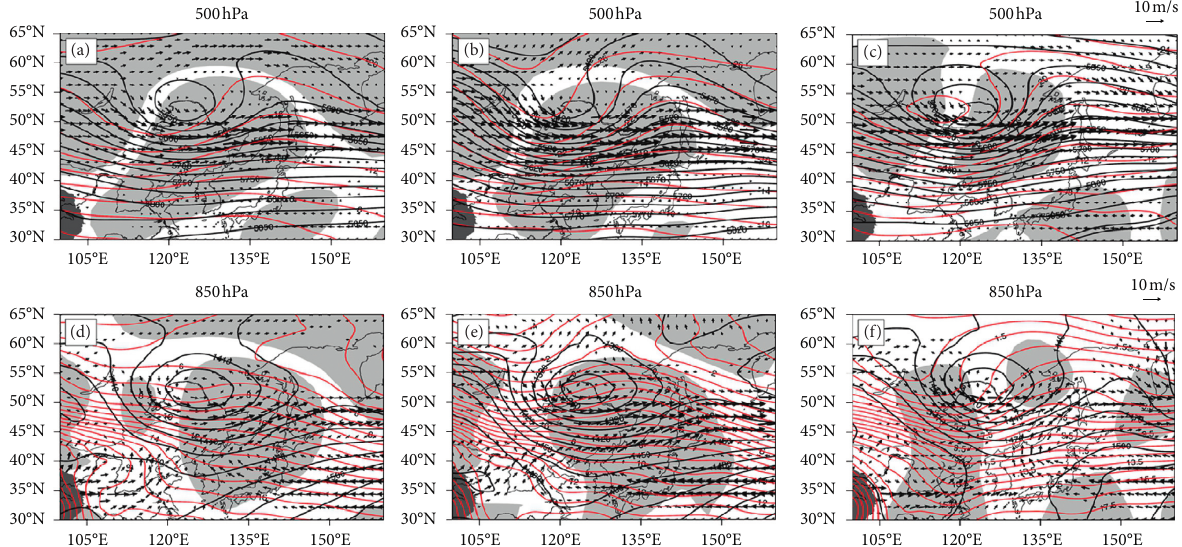
Figure 9: Composite fields of temperature (red contours, unit: ° C), wind (vectors), and geopotential height (black contours, unit: gpm) for NCVs in (a) May-September, (b) late spring, and (c) early autumn, respectively. Areas with grey color are those reaching 95% significance test; a darker area at the southwest of the maps is the Qinghai Tibet plateau. A and C indicate the temperature and wind fields at 500hPa and 850hPa, respectively. B and D indicate the geopotential height fields at 500hPa and 850hPa,